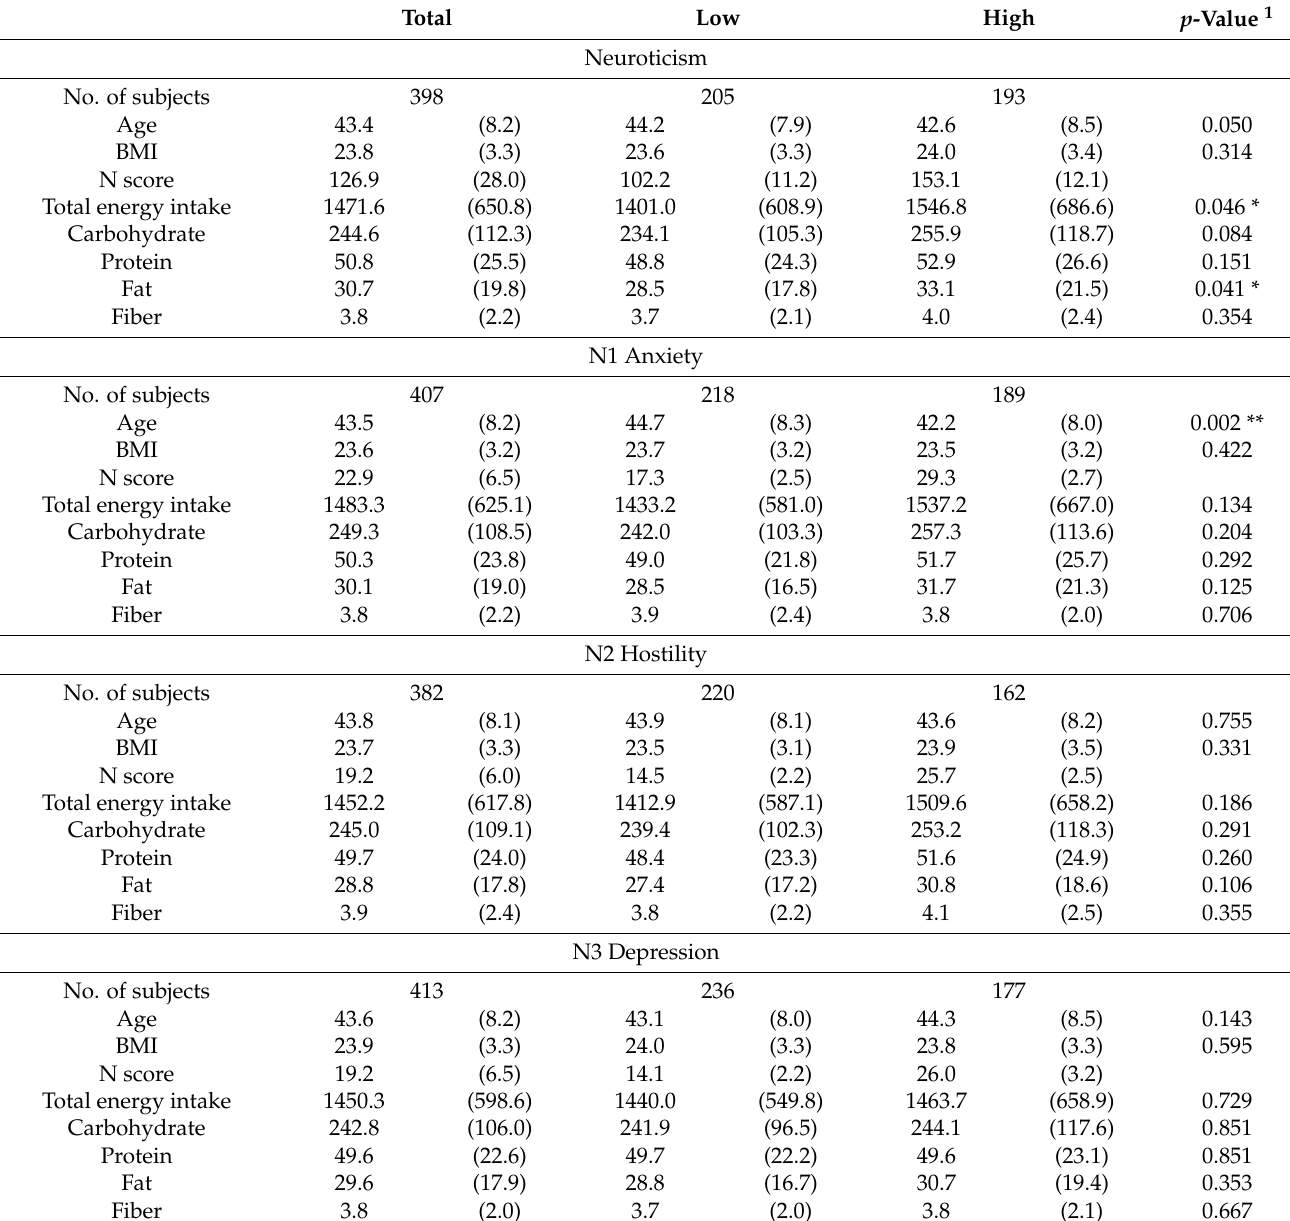
Table 1. Baseline characteristics of study participants according to neuroticism score. Total Low